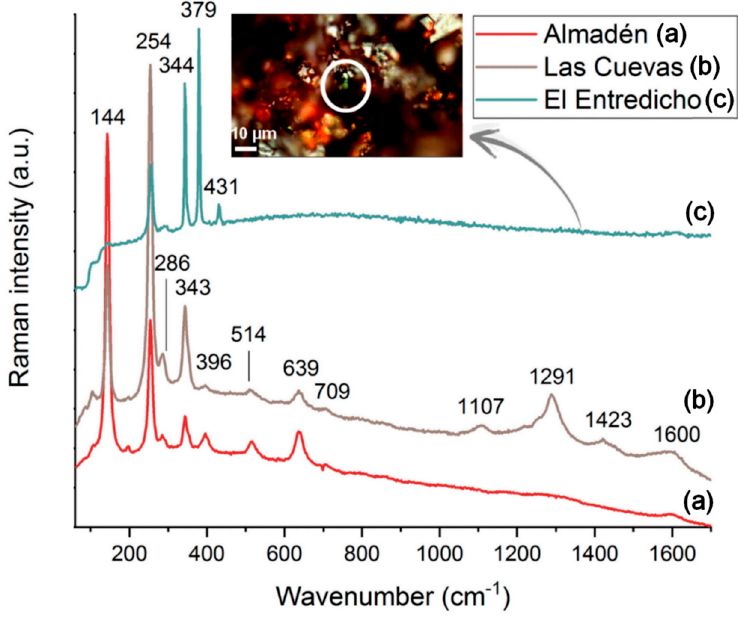
Figure 2. Raman spectra acquired on the surface of the ores of the Almad é n mining district using the portable spectrometer (Almad é n ( a ), Las Cuevas ( b )) and the confocal instrument (El Entredicho ( c )).